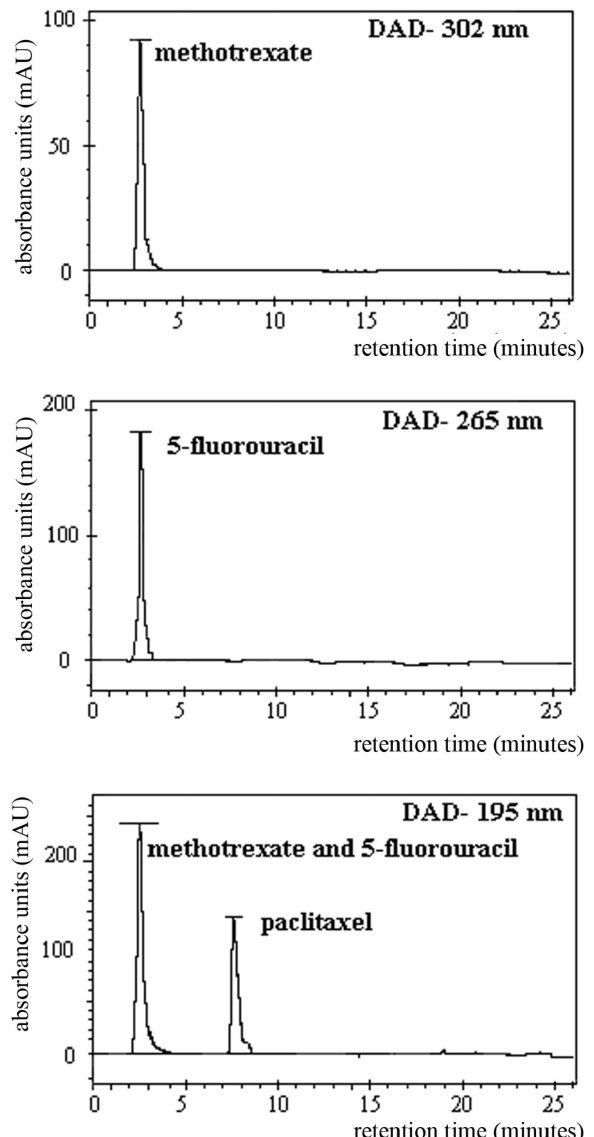
FIGURE 3 - Typical chromatogram for methotrexate, 5-fluorouracil and paclitaxel (5 µg mL -1 ), in a single run, detected at three wavelengths on a Shimadzu SPD-M10Avp (Kyoto, Japan) diode array detector (DAD); mobile phase: water (pH 4)-methanol-acetonitrile (35:15:50, v/v/v); column: Supelcosil TM LC-18 (250 x 4.6 mm, 5 m m) protected by a C18 guard-column (4 x 4.6 mm, 5 m